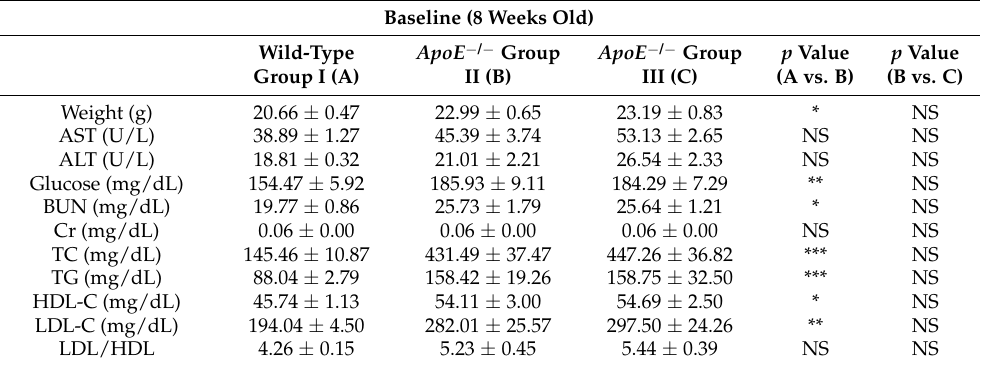
Table 1. Biochemical parameters in all the three groups of mice at their